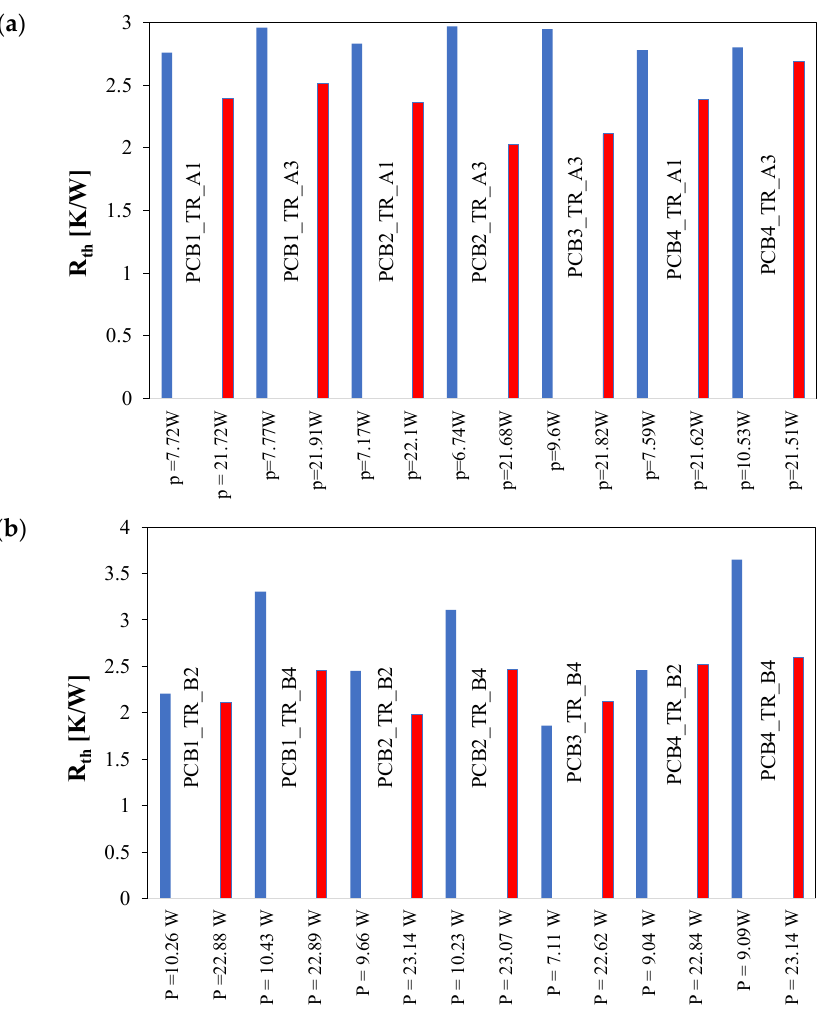
Figure 14. Comparison of the measured R th values of the tested transistors with the considered power values, BLC10G22LS-240PVT ( a ) and BLC9G22LS-160VT ( b ).